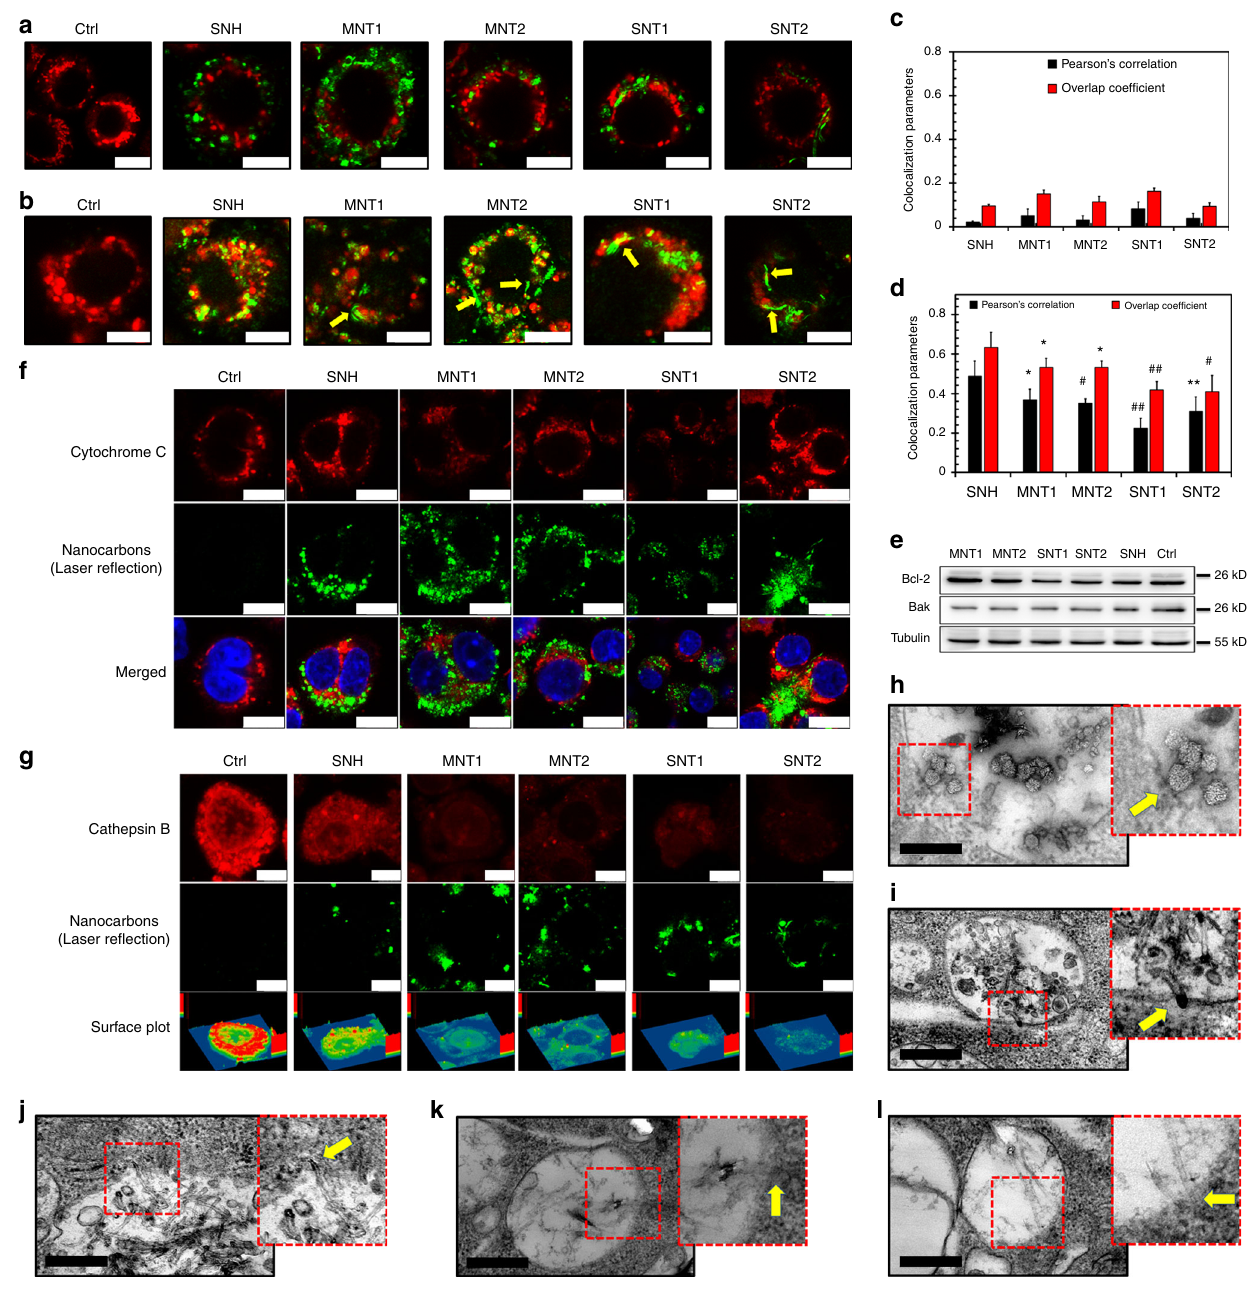
Fig. 6 SNH initiated less lysosome stress than CNT. a Co-localization images of intracellular nanocarbons (pseudo green color, laser re fl ection detection) with mitochondria (red color, labeled with MitoTracker) detected by CLSM. Scale bar: 7.5 μ m. b Co-localization images of intracellular nanocarbons (pseudo green color, laser re fl ection detection) with lysosomes (red color, labeled with LysoTracker) viewed by CLSM. Yellow arrows indicated the penetrations of CNT through lysosome membrane. Scale bar: 7.5 μ m. c , d Co-localization parameter measurements of different nanocarbons with c mitochondria and d lysosomes respectively based on CLSM investigations ( n = 5). e Western blot analyses of Bcl-2 and Bak after nanocarbon incubations. f , g Intracellular distribution images of two organelle-speci fi c proteins, f Cytochrome C (mitochondria location) and g Cathepsin B (lysosome location) after the cellular incubations of nanoarbons. Scale bar in f and g : 10 μ m. h – l Transmission electron microscopy images of the interactions of different nanocarbons with lysosome membrane. The insert graphs indicated the moderate contact of h SNH with membrane, and the striking membrane penetrations for i MNT1, j MNT2, k SNT1, and l SNT2. Scale bar in h – l : 500 nm. In c and d , data were presented as means ± s.d. Statistical signi fi cances were calculated by Student ’ s t -test. Data were all compared with control (Ctrl) group: * p < 0.05, ** p < 0.01, # p < 0.005, ## p <